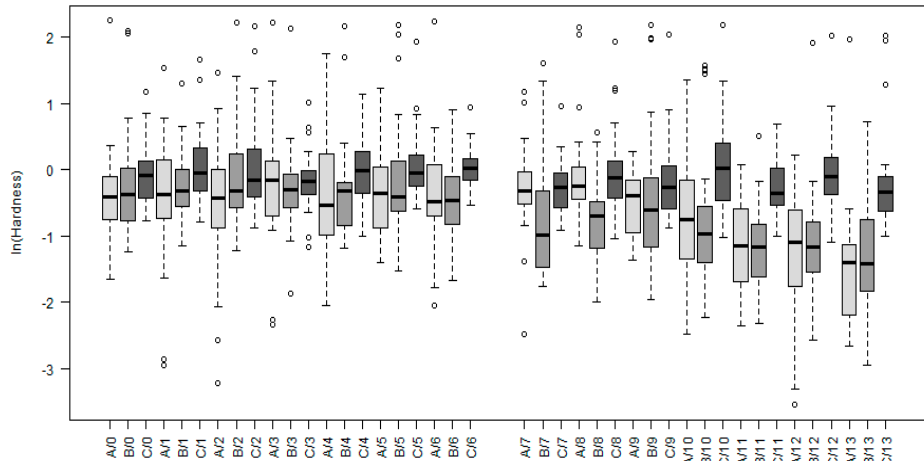
Figure 4. Boxplots of hardness measured on three samples differing in thickness of the root canal wall (A–0.8 mm, B–1.2 mm, C–1.6 mm). The measurements were taken on different locations, where 0 denotes measurements in the center of a sample and 13 on the periphery. Indexes 0–6, therefore, represent measurements in the central matrices and 7–13 measurements in the peripheral ones.